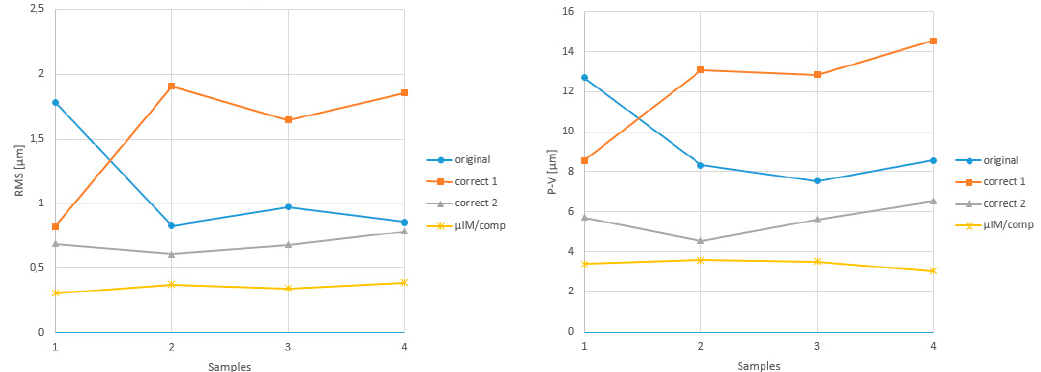
Figure 4. RMS and PV-values of intermediate states of the process optimization for four samples, respectively. “original” means the initial setting.